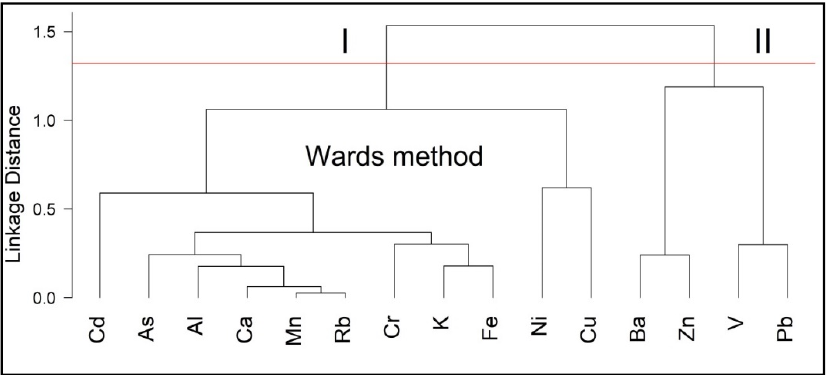
Figure. 4. Results of the hierarchical cluster analysis (dendrogram) of the trace element concentrations measured in PM 2.5.